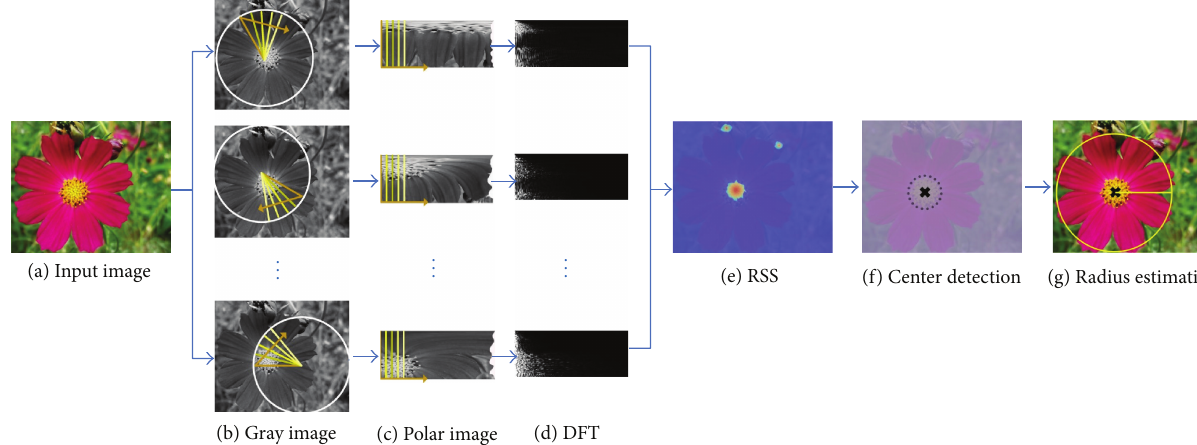
Figure 1: Flowchart of the proposed